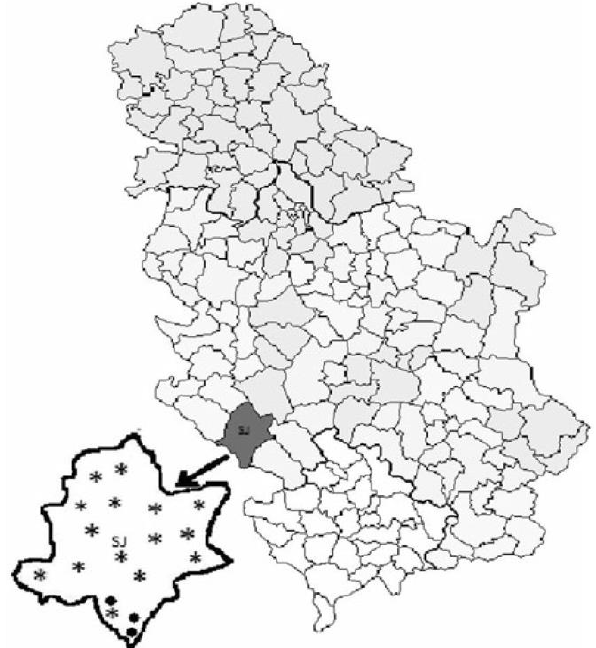
Figure 1. Distribution of the 15 apiaries with commercially kept hives (designated with stars) and 3 apiaries with traditionally kept hives (designated with black dots), from where samples were collected in the Pester plateau (Serbia) [1].